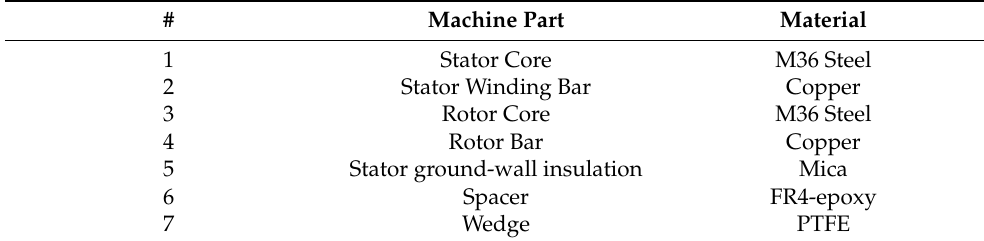
Figure 9. 2D FEA model of the medium-voltage machine. Different parts of the motor are num- Table 3. Parts of medium voltage machine in Ansys Maxwell FEM bered and listed in Table 3.